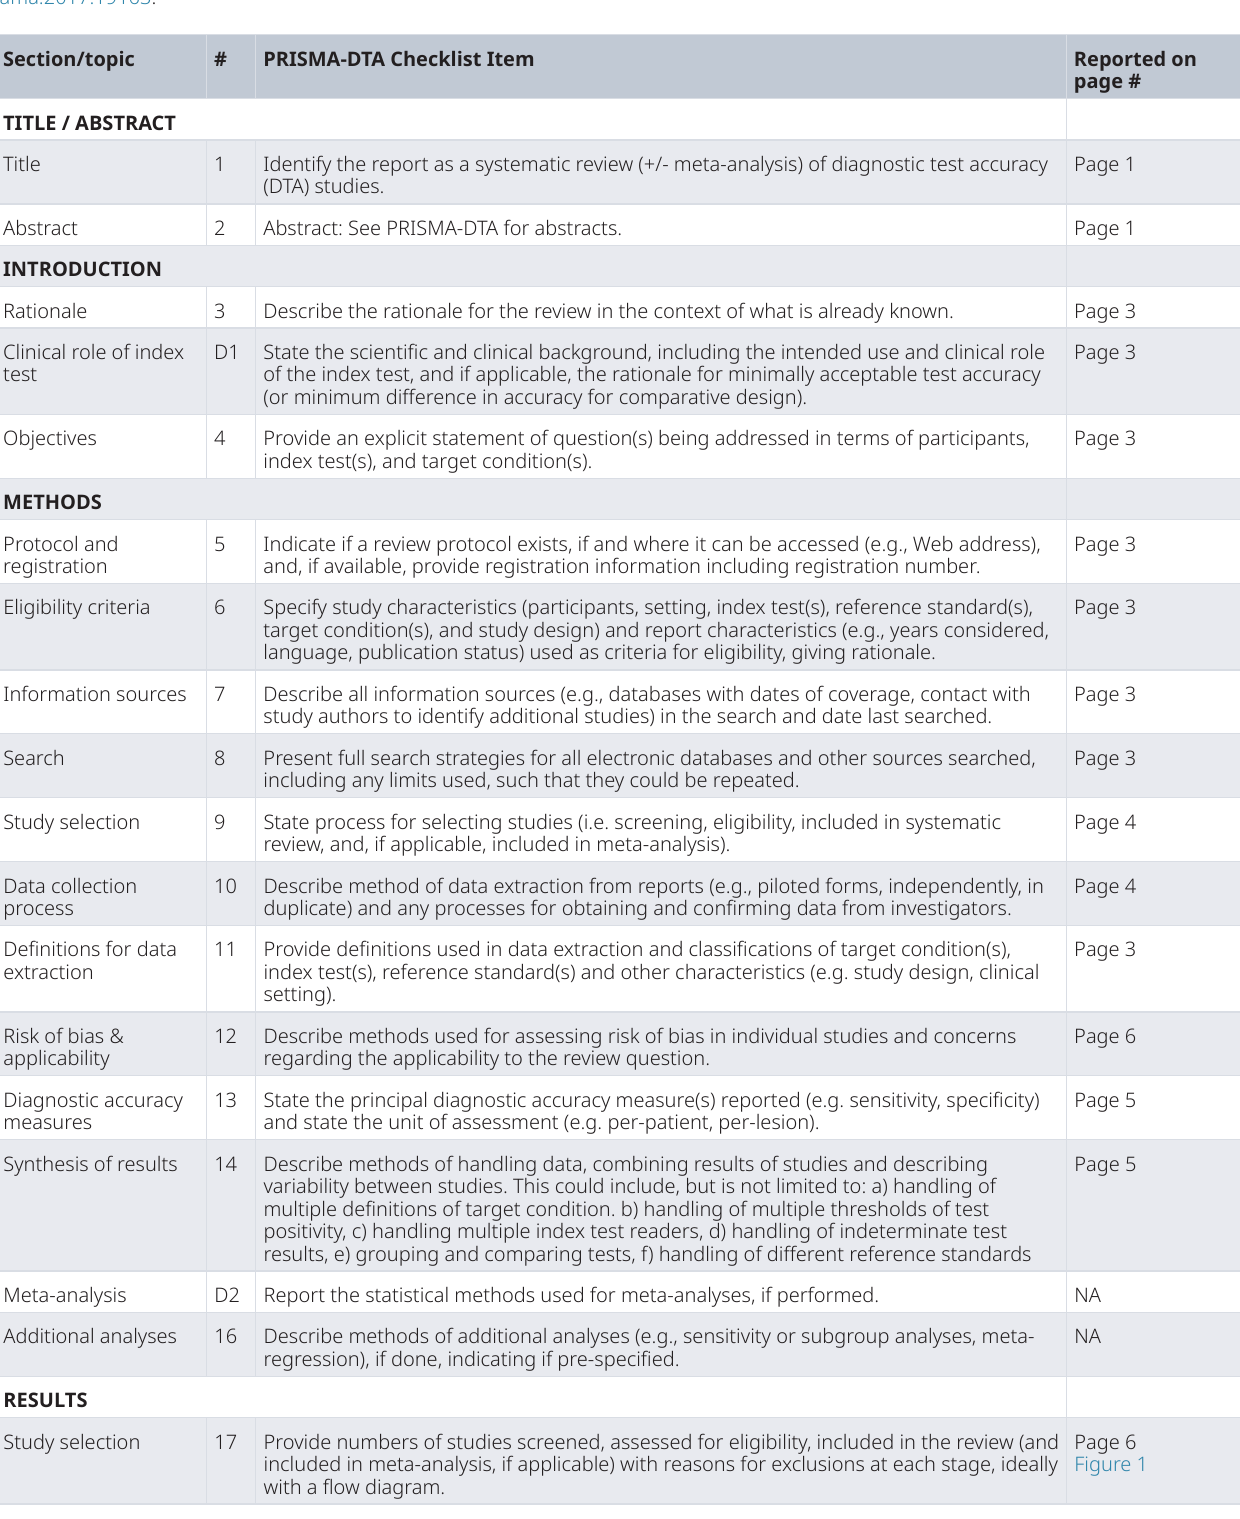
Table 1. PRISMA for Diagnostic Test Accuracy 2018 checklist. This checklist has been adapted from McInnes MDF, Moher D, Thombs BD, McGrath TA, Bossuyt PM, The PRISMA-DTA Group (2018). Preferred Reporting Items for a Systematic Review